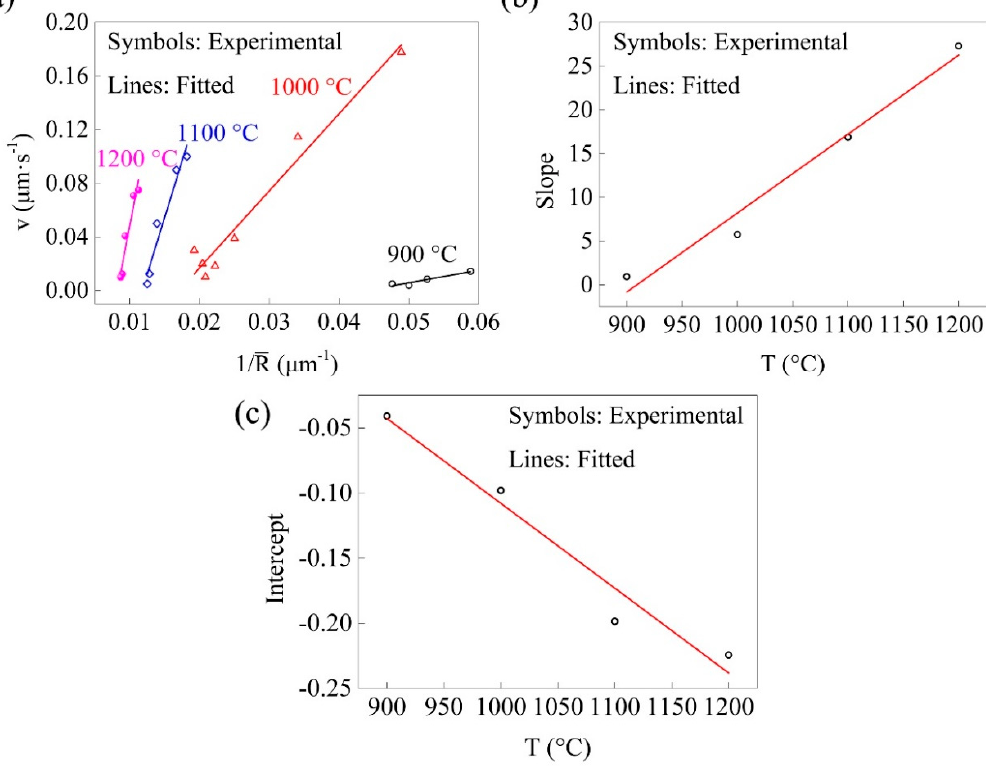
Figure 12. Calculation procedure to obtain the model parameters. It shows ( a ) the relationship between v and 1/ R (cid:3365) ; ( b ) the slope of the fitted lines of v and 1/ R (cid:3365) ; and ( c ) the intercept of the fitting lines of v and 1/ R (cid:3365) .